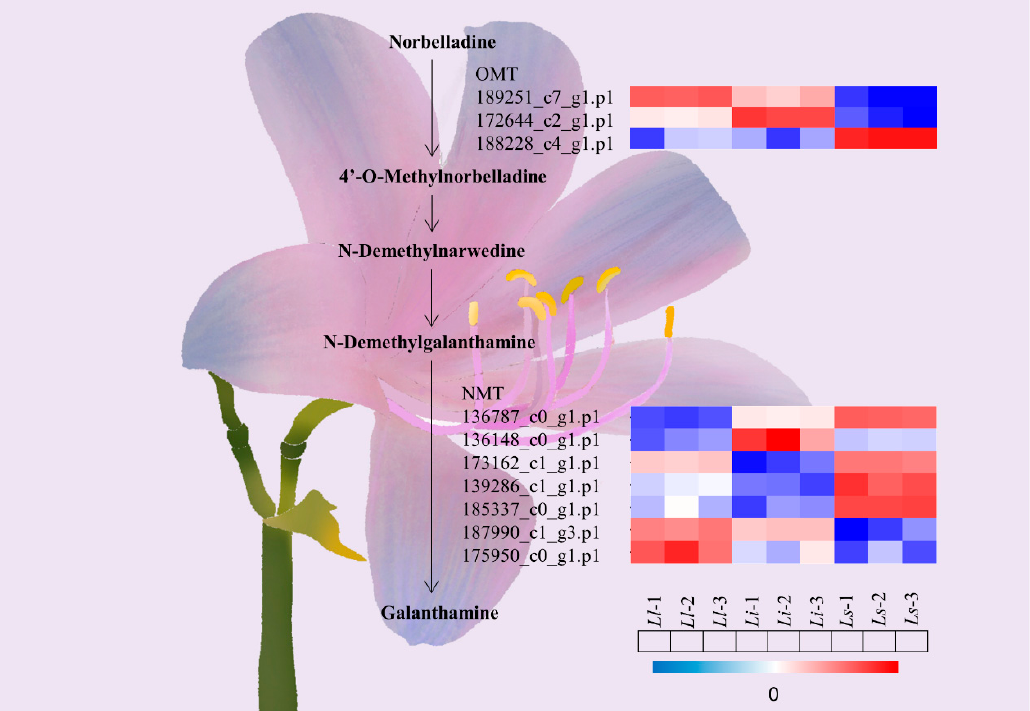
Figure 4. Candidate genes responsible for the biosynthesis of galanthamine in Lycoris . 189251_c7_g1.p1 and 175950_c0_g1.p1 and other genes upregulated in Ll , which provide the raw